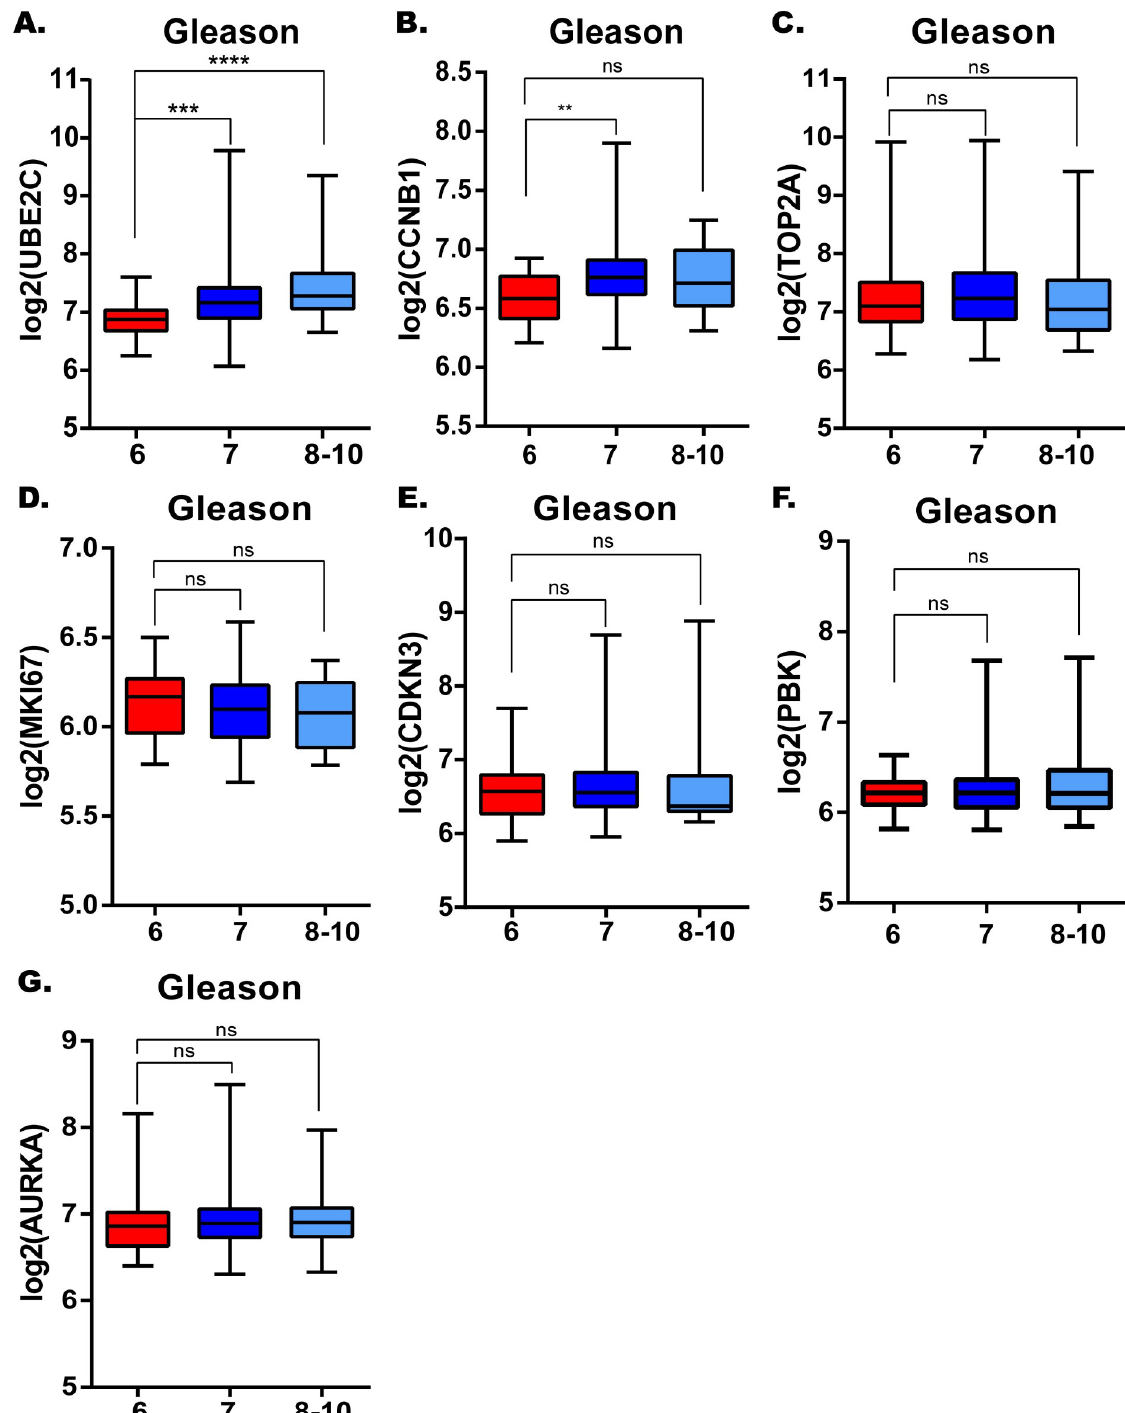
Fig 5. The correlations between candidate hub genes and Gleason score. UBE2C. (B) CCNB1. (C) TOP2A. (D) MKI67. (E) CDKN3. (F) PBK. (G) AURKA. � : p < 0.05; �� : p < 0.01; ��� : p < 0.001; ���� : p < 0.0001.